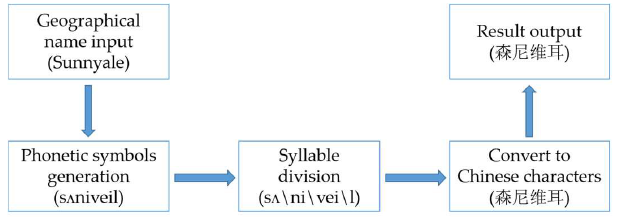
Figure 4. Automatic transliteration technology framework for geographical names.